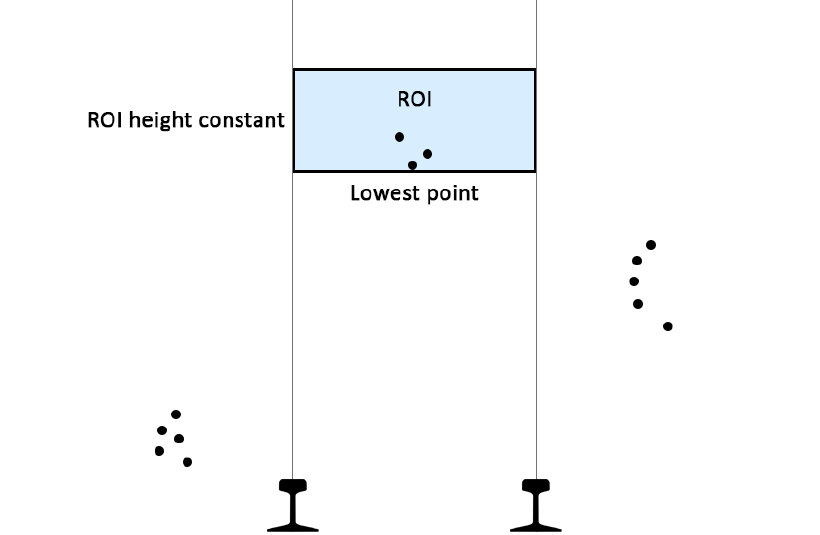
Figure 4. Region of interest computation